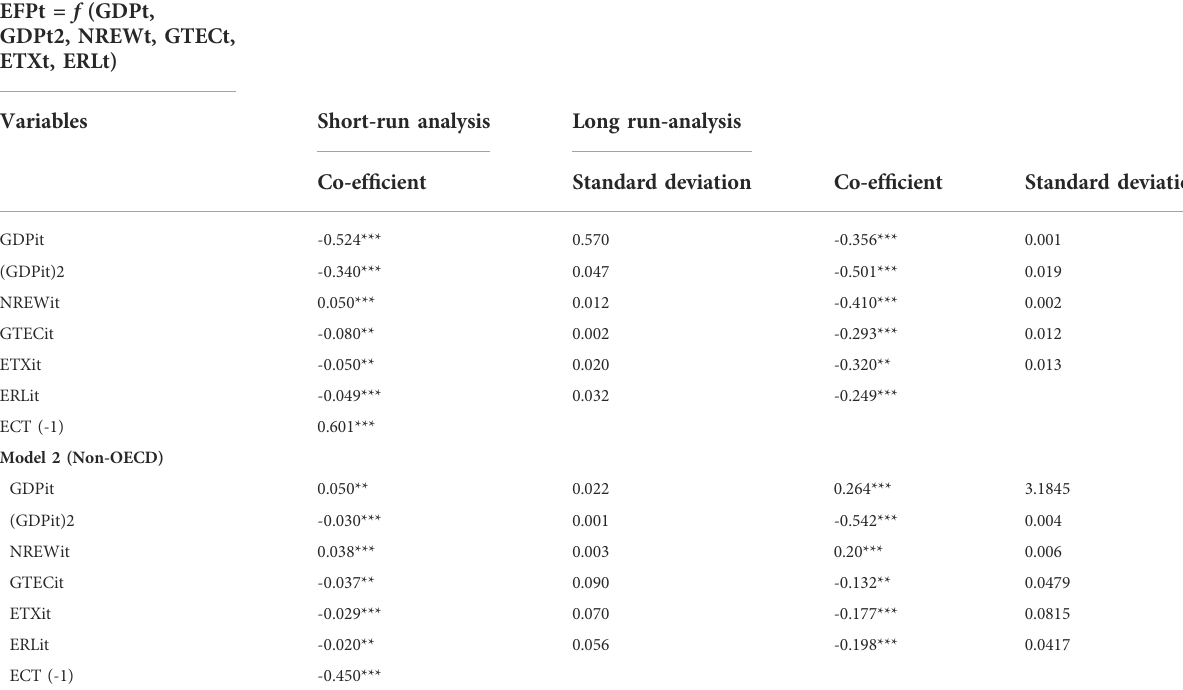
TABLE 6 Statistical fi ndings of